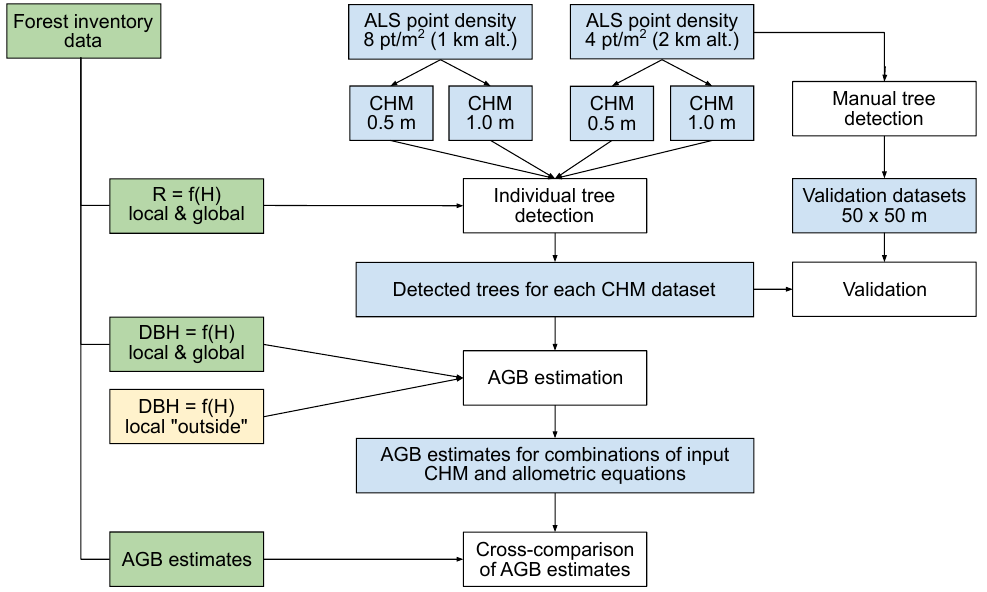
Figure 1. Methodological design of this study (DBH = diameter at breast height, R = crown radius, H = tree height, AGB = aboveground biomass, ALS = airborne laser scanning, CHM = canopy height model).